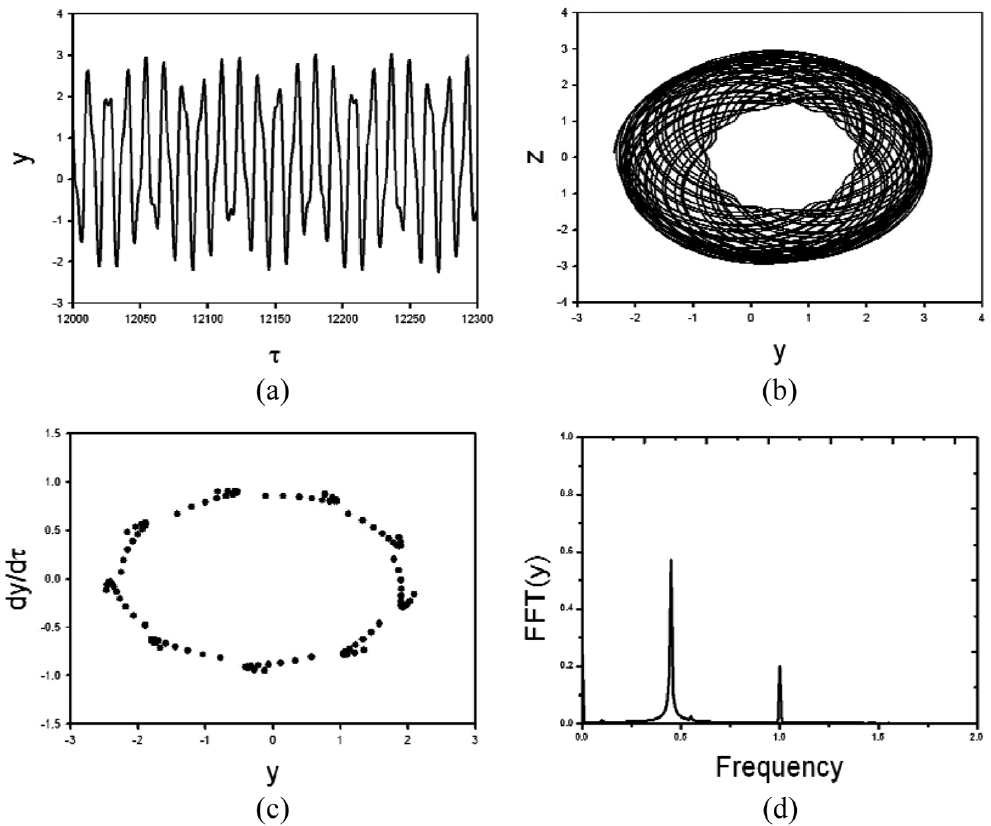
Fig. 13. Dynamic characteristic of the y-displacement of the mid-span point with ω = 740 rad/s. (a) Time history; (b) Orbital trajectory; (c) Poincar´e section; (d) FFT.